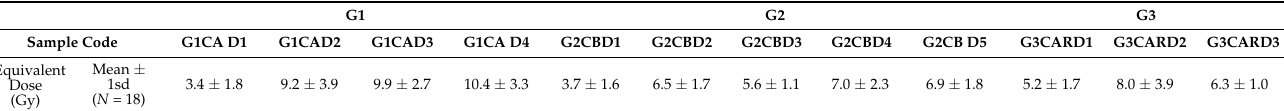
Table 4. Equivalent doses estimated with OSL dose response curve lines. G1 G2 G3